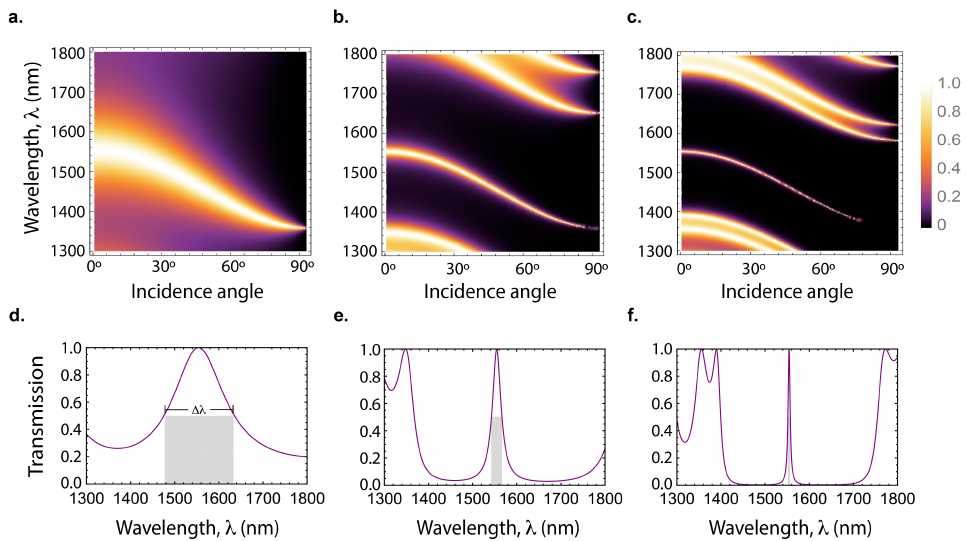
Figure 3. Optical filter response in the whole range of incident angles, for period numbers ( a ) N = 2, ( b ) N = 5, and ( c ) N = 8; T = 80 K and d s = 30 nm. The resonant peak becomes thinner with increasing N and angle of incidence, which act as key parameters in the quantification of the filtered signal quality. Panels ( d – f ) present the transmission spectra of the 1D tunable resonant filter ( BTO/Y 2 O 3 ) N /YBCO/ ( Y 2 O 3 /BTO ) N at normal incidence, as a function of the wavelength and the filter’s period number. The graphs show a 100% peak at defect resonance wavelength λ c = 1550 nm for ( d ) N = 2, Q ∼ 10, ( e ) N = 5, Q ∼ 66, and ( f ) N = 8, Q ∼ 470. The gray shaded regions indicate the FWHM transmission characterized by ∆ λ . The quality factor Q ≡ λ c / ∆ λ scales exponentially with N